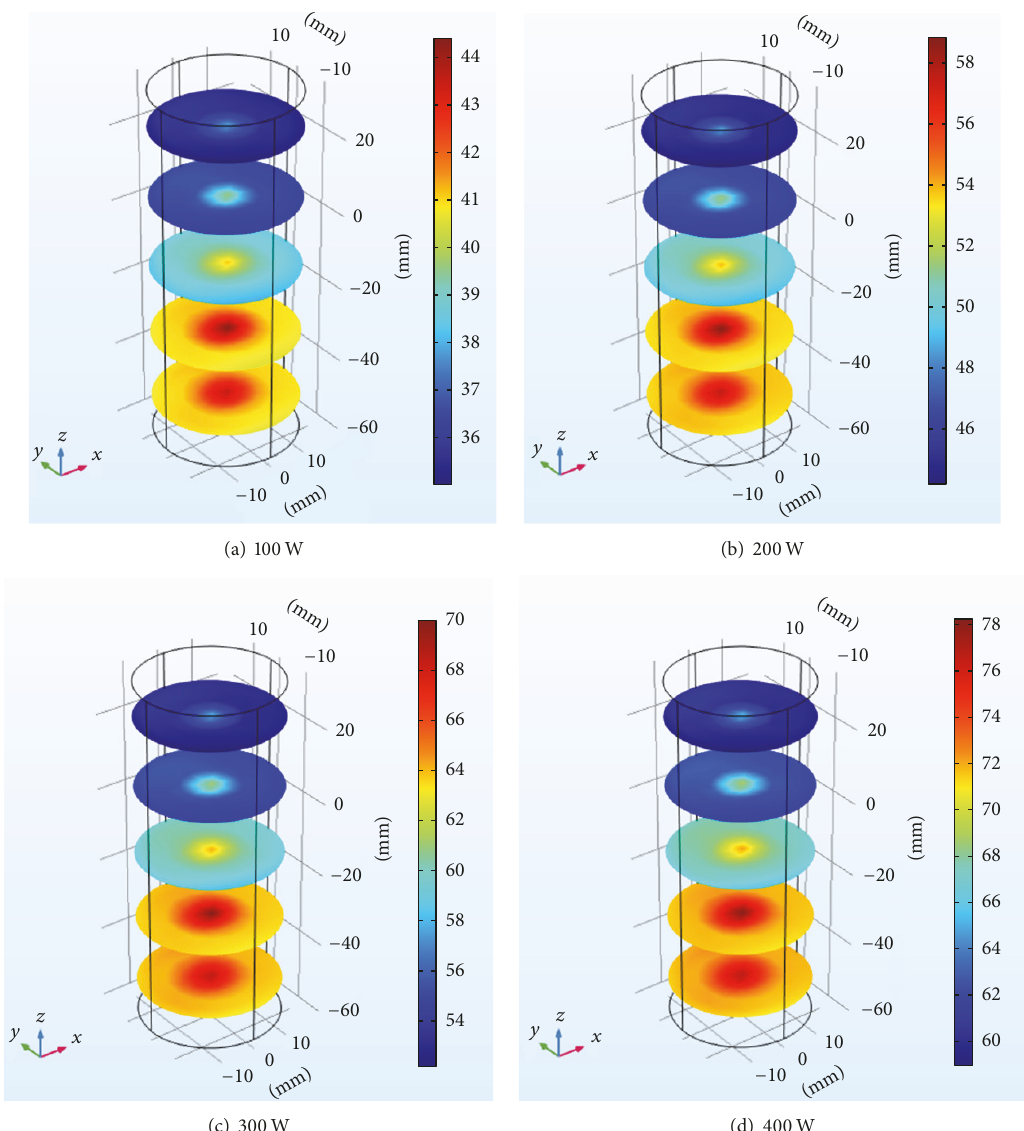
Figure 5: Distribution of temperature in extraction vial under 4 microwave powers (ethanol concentration of 60%, ratio of solid to liquid of 1: 30, and extraction time of 80